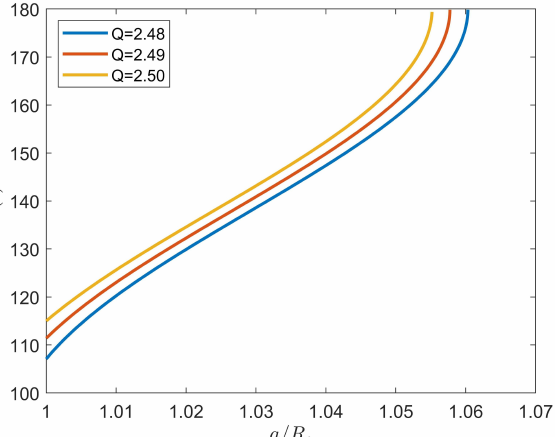
Figure 5. The relation between a and i of repeating ground track orbits for repetition parameter Q = 2.48,2.49, and